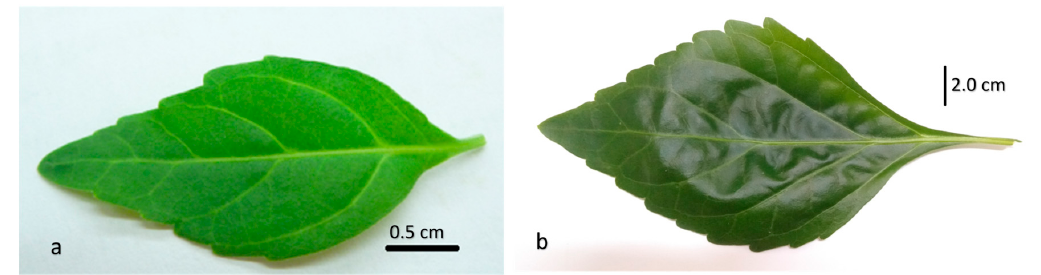
Figure 3. Morphology of leaves of Orthosiphon stamineus ; ( a ) in vitro grown plantlet, and ( b ) mother